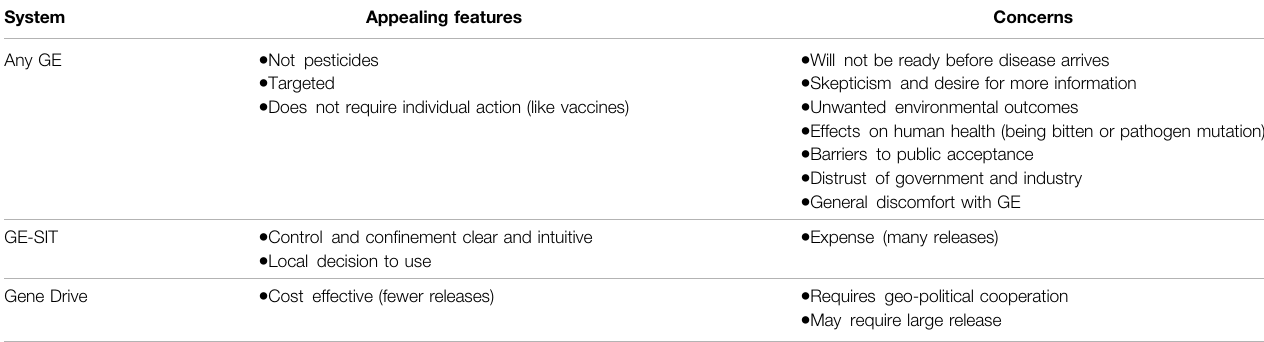
TABLE 3 | Comparison of appealing features and concerns raised by focus group participants for the presented technologies. System Appealing